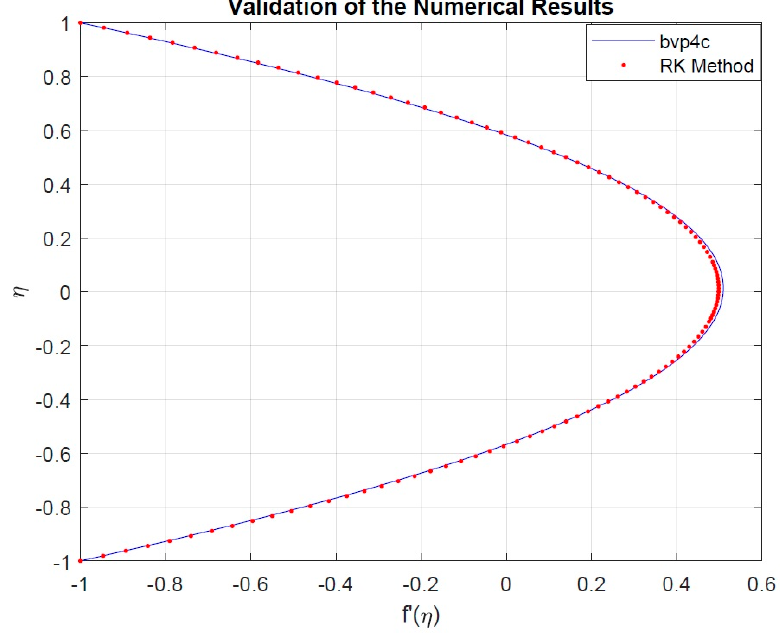
Figure 2. Code verification.